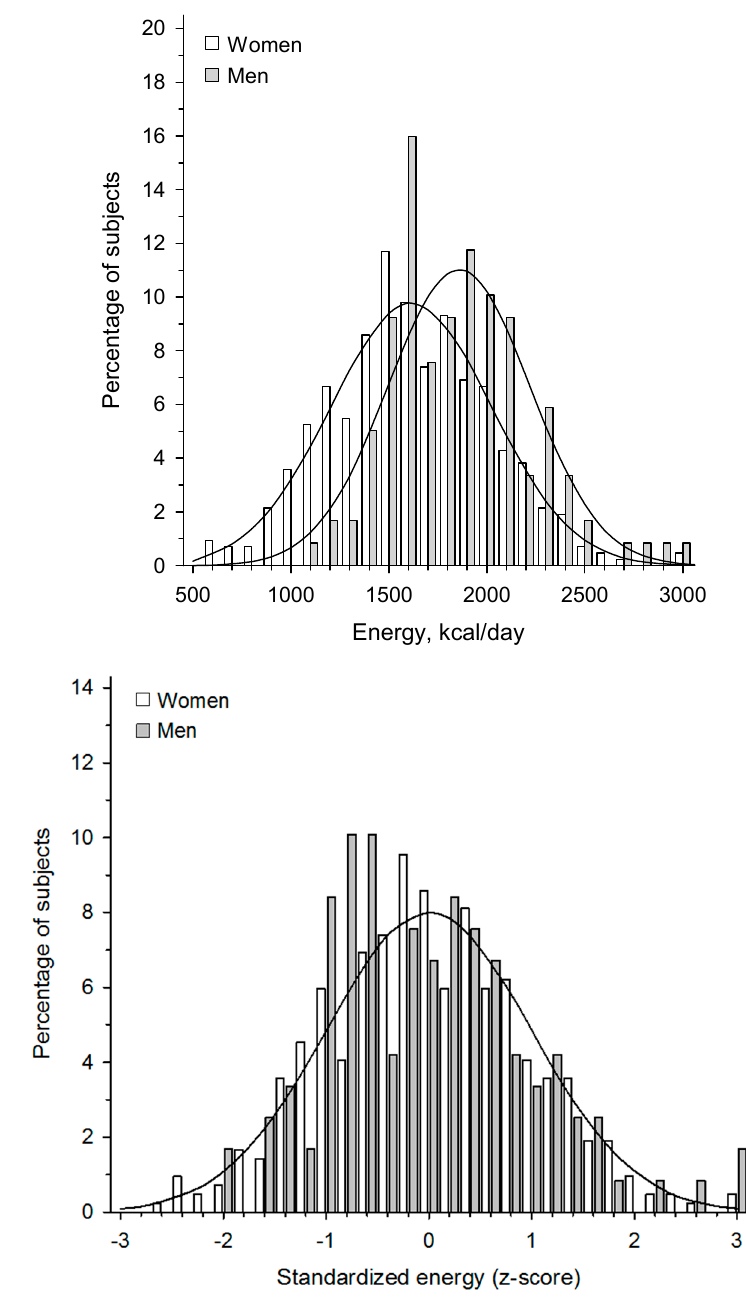
Figure 1. Distribution with normal curve overlay of energy intake / day in women and men ( A ) and standardized ( z -score) energy intake / day ( B ). Energy intakes were standardized by z -scores to include both men and women in the same analyses.